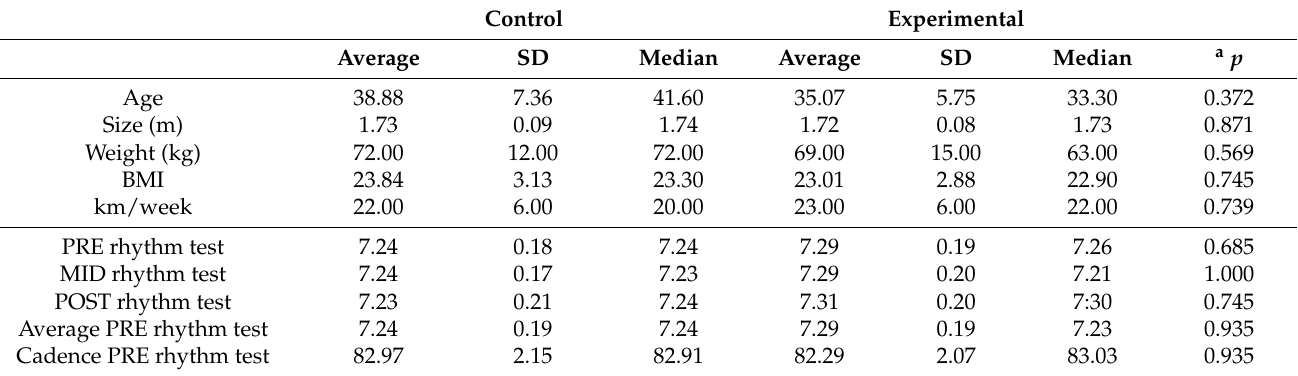
Table 2. Baseline description of the sample according to control group or experimental